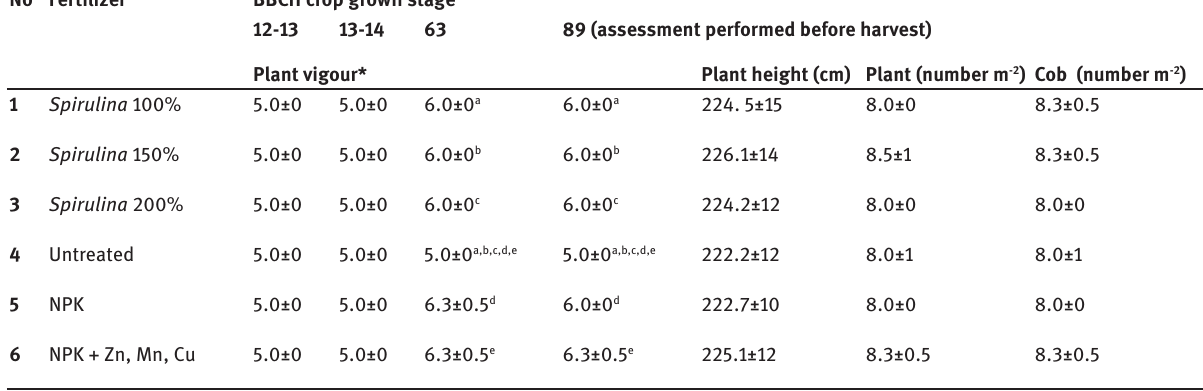
Table 3: Plant vigour, height, number and cob number per 1m 2 . No